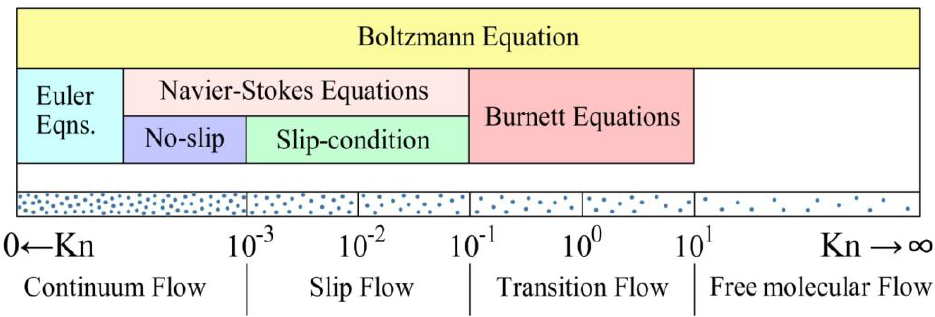
Figure 2. Classification of rarefied gas flow regimes based on the Knudsen number (Kn) and the applicable governing equations for each regime.